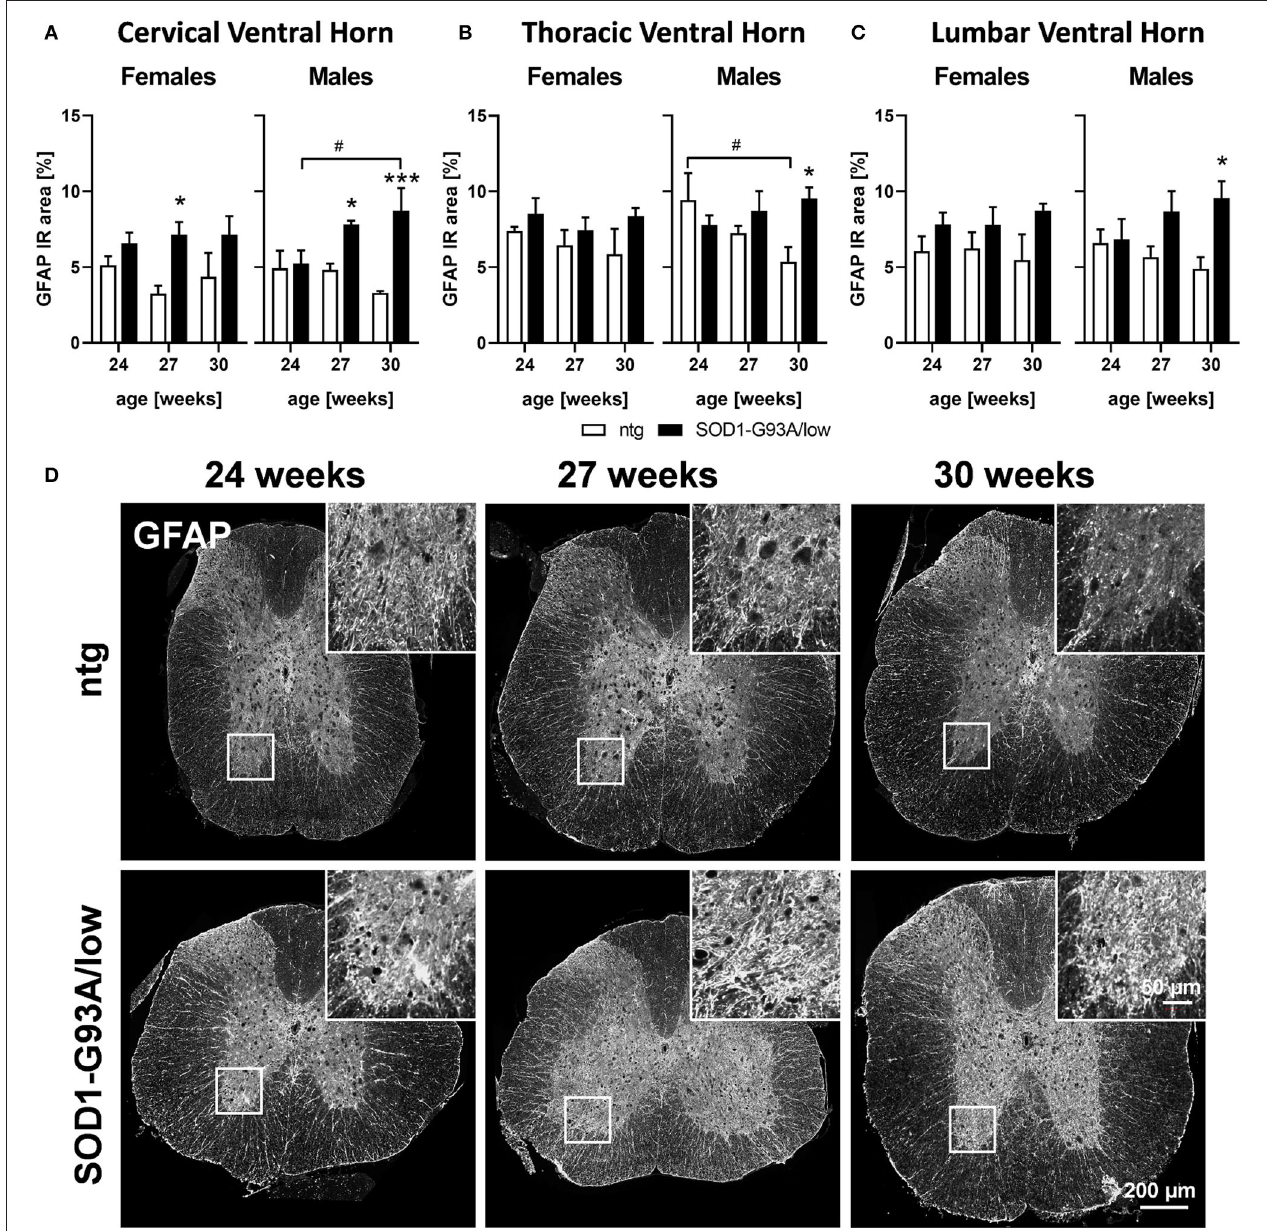
FIGURE 2 | Astrocytosis in the spinal cord of 24–30 weeks old SOD1-G93A/low mice. Female and male 24, 27, and 30 weeks old SOD1-G93A/low mice were evaluated for glial fibrillary acidic protein (GFAP) expression (A–C) in the cervical (A) , thoracic (B) , and lumbar (C) ventral horn compared to ntg littermates. Two-way ANOVA with Tukey’s and Sidak’s multiple comparison post hoc test; n = 4 per group. Mean + SEM. * / # p < 0.05, *** p < 0.001. *Differences between genotypes; # differences between age groups. (D) Representative images of GFAP labeling in the thoracic spinal cord of 24, 27, and 30 weeks old male SOD1-G93A/low mice compared to ntg